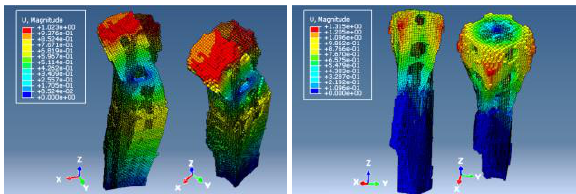
Figure 14. Axial mode (left) and torsional mode